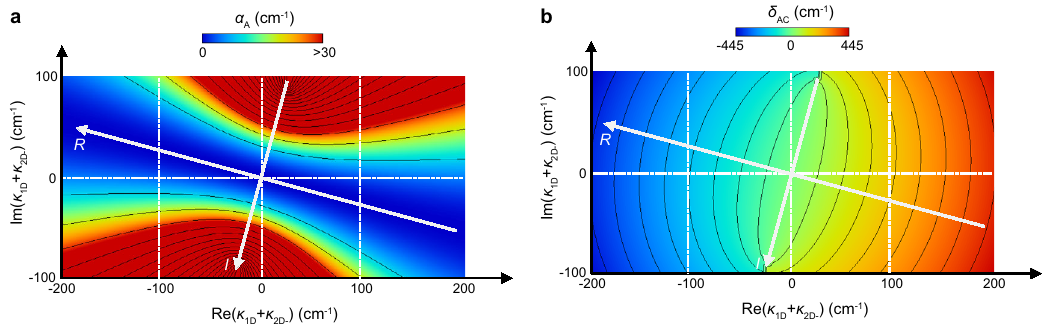
Fig. 3 Control of radiation constant and frequency difference via Hermitian coupling coef fi cient. a Radiation constant of mode A. The interval of the contour lines is 10 cm − 1 . b Frequency gap δ AC between modes A and C. The interval of the contour lines is 50 cm −